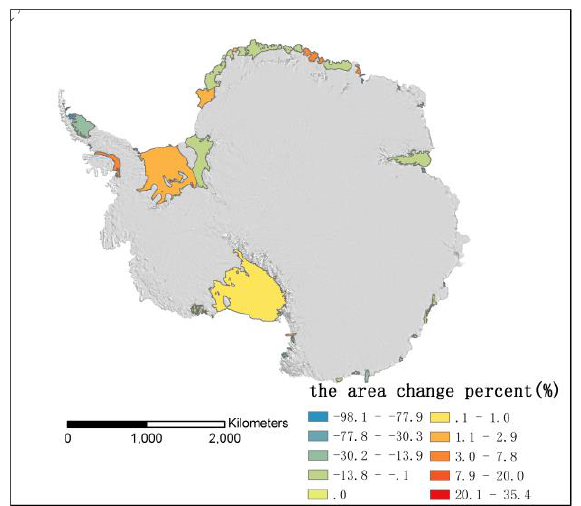
Figure 2. The area change rate of ice shelves between 1963 and